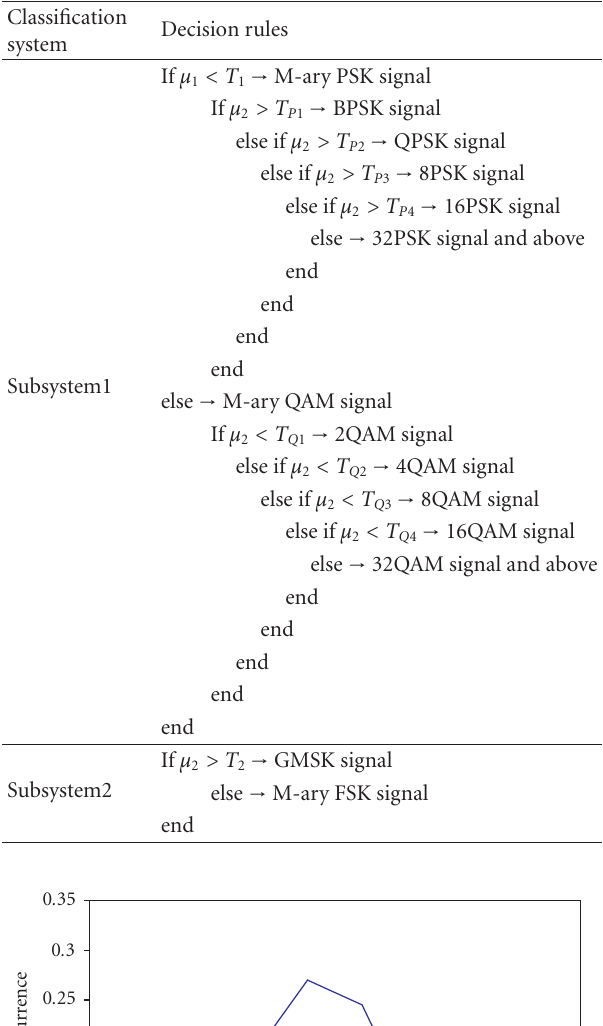
Table 1: Subsystem classification—decision rule.